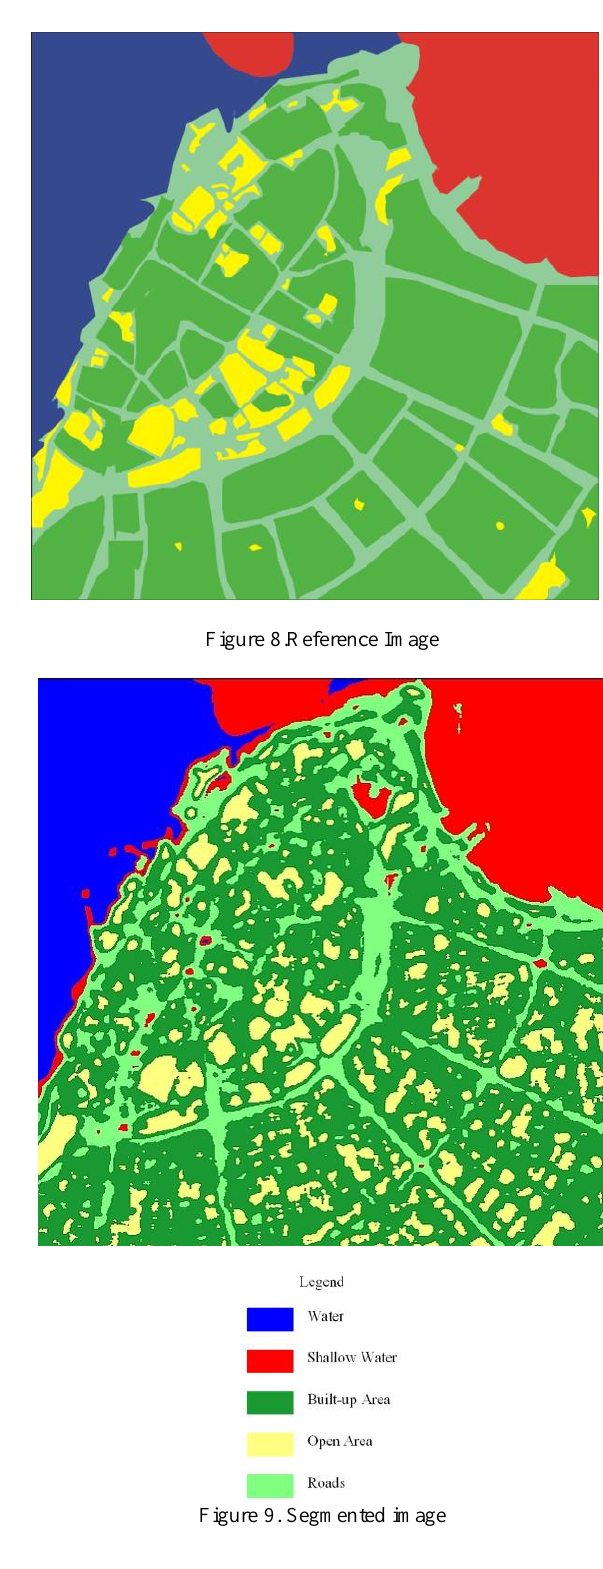
Figure 9. Segmented